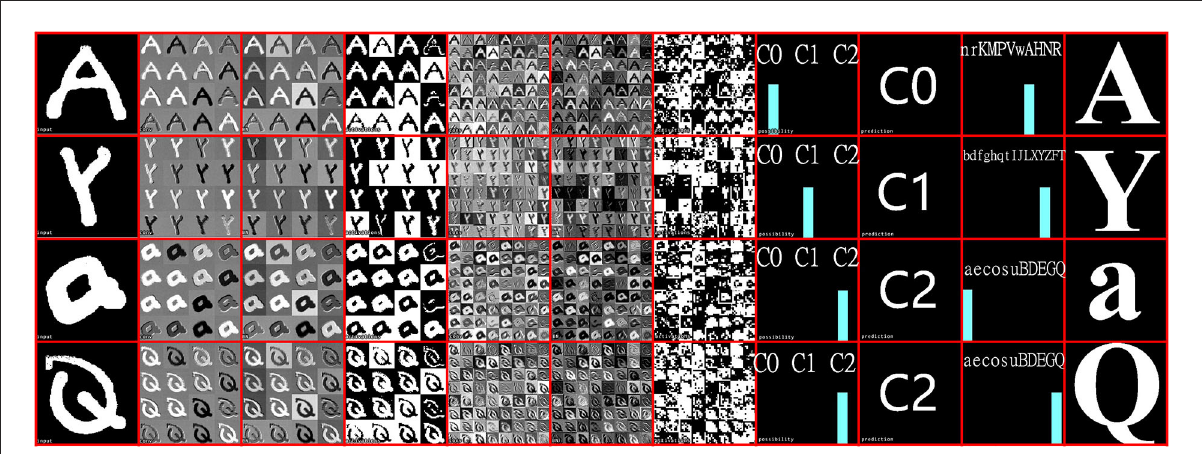
FIGURE12 Examples of CNN tree inference on SCAMP-5d. For each letter from left to right: (1) Real-time hand-written input image by facing the SCAMP to a writing pad. (2) first convolutional layer. (3) convolutional layer after batch norm. (4) binary feature maps after maxpooling and activation function. (5) second convolutional layer. (6) convolutional layer after batch norm. (7) binary feature maps for fully-connected layer after maxpooling and activation function. (8) prediction bar for first CNN inference results (Category 0, 1, 2). (9) Switch CNN inference results. (10) prediction bar for the second CNN inference results. (11) final CNN inference results. Notice that for each letter inference process, visualization is only for one